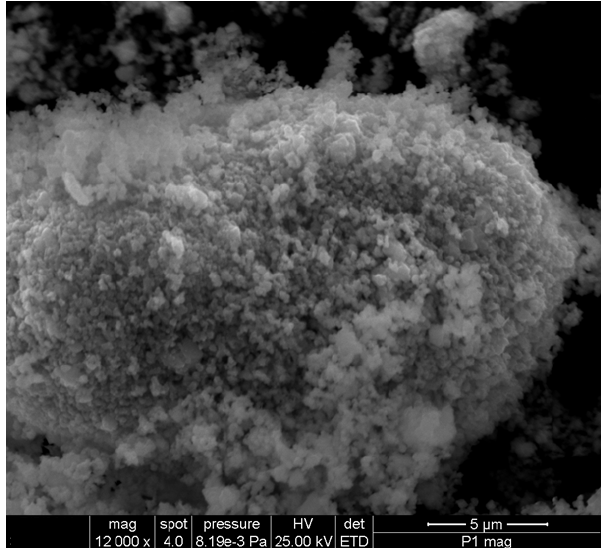
Figure 10. High-resolution SEM images of Fe 3 O 4 nanoparticles.